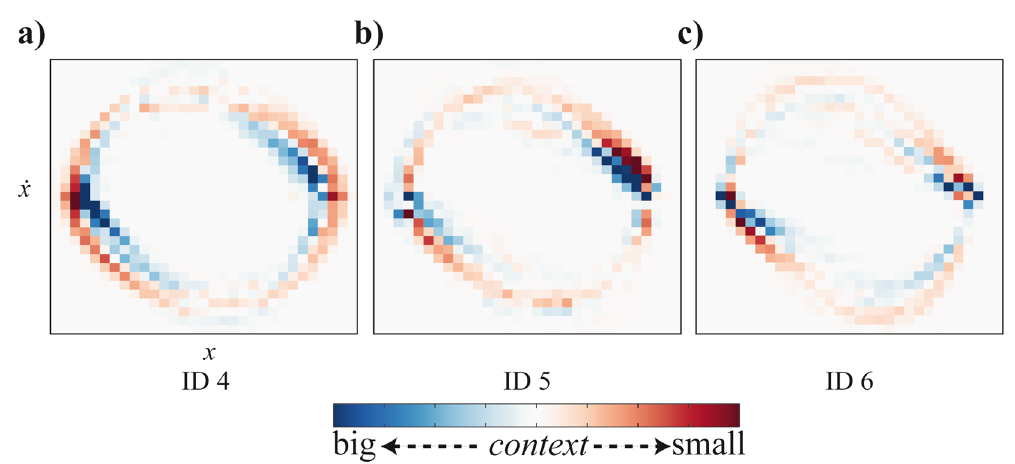
Figure 5. Difference probability distribution for ( a ) ID 4, ( b ) ID 5, and ( c ) ID 6. The red colouring marks a higher probability for the small context condition; the blue colouring signifies higher probabilities for the big context